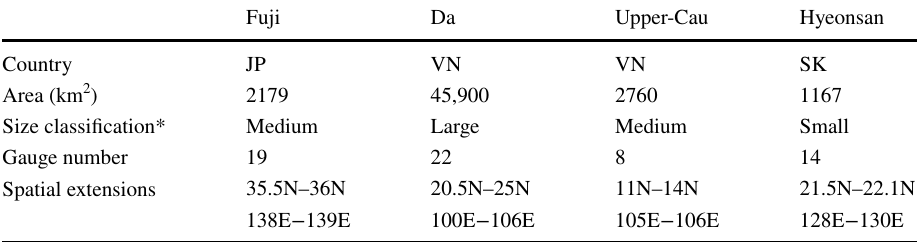
characteristics of the study